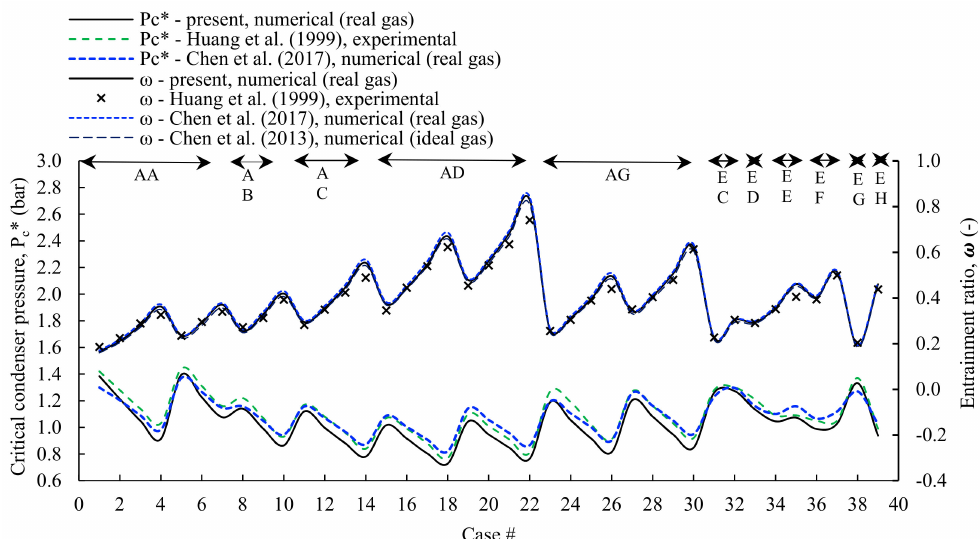
Figure 4. Comparison of ejector critical back pressure and entrainment ratio predictions in critical operation mode as a function of primary and secondary flow pressures and temperatures, critical condenser inlet pressure and temperature, and ejector primary nozzle geometrical parameters, with the corresponding experimental data of Huang et al. [21], and numerical data of Chen et al. [20,57], for R141b. AA, AB, AC, AD, AG, EC, ED, EE, EF, EG, and EH refer to the ejector geometries of Huang et al. [21].